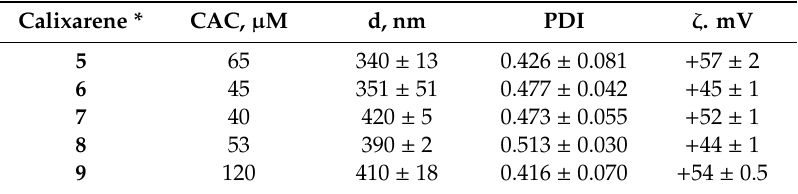
Figure 2. Dependence of I 1 / I 3 pyrene ratio vs. lg(C) of 5 – 9 , C (pyrene) = 1 µ M in ultrapure water, 25 ◦ C. Figure 2. Dependence of I 1 /I 3 pyrene ratio vs. lg(C) of 5 – 9 , C (pyrene) = 1 μ M in ultrapure water, 25 °C. Table 1. Critical aggregation concentration (CAC) values, dynamic light scattering (DLS) and electrophoretic (ELS) data of aggregates formed by macrocycles 5 – 9 . Calixarene Figure 2. Dependence of I 1 /I 3 pyrene ratio vs. lg(C) of 5 – 9 , C (pyrene) = 1 μ M in ultrapure water, 25 °C.